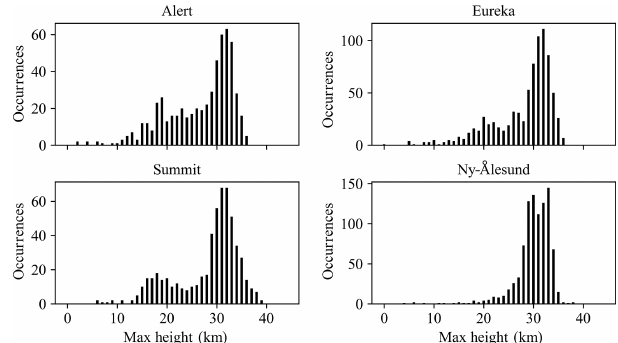
Figure 2. Maximum height reached by ozonesondes launched at Alert, Nunavut, Canada; Eureka, Nunavut, Canada; Summit Station, Greenland; and Ny-Ålesund, Svalbard, Norway, between Febru- ary 2005 and February 2017.